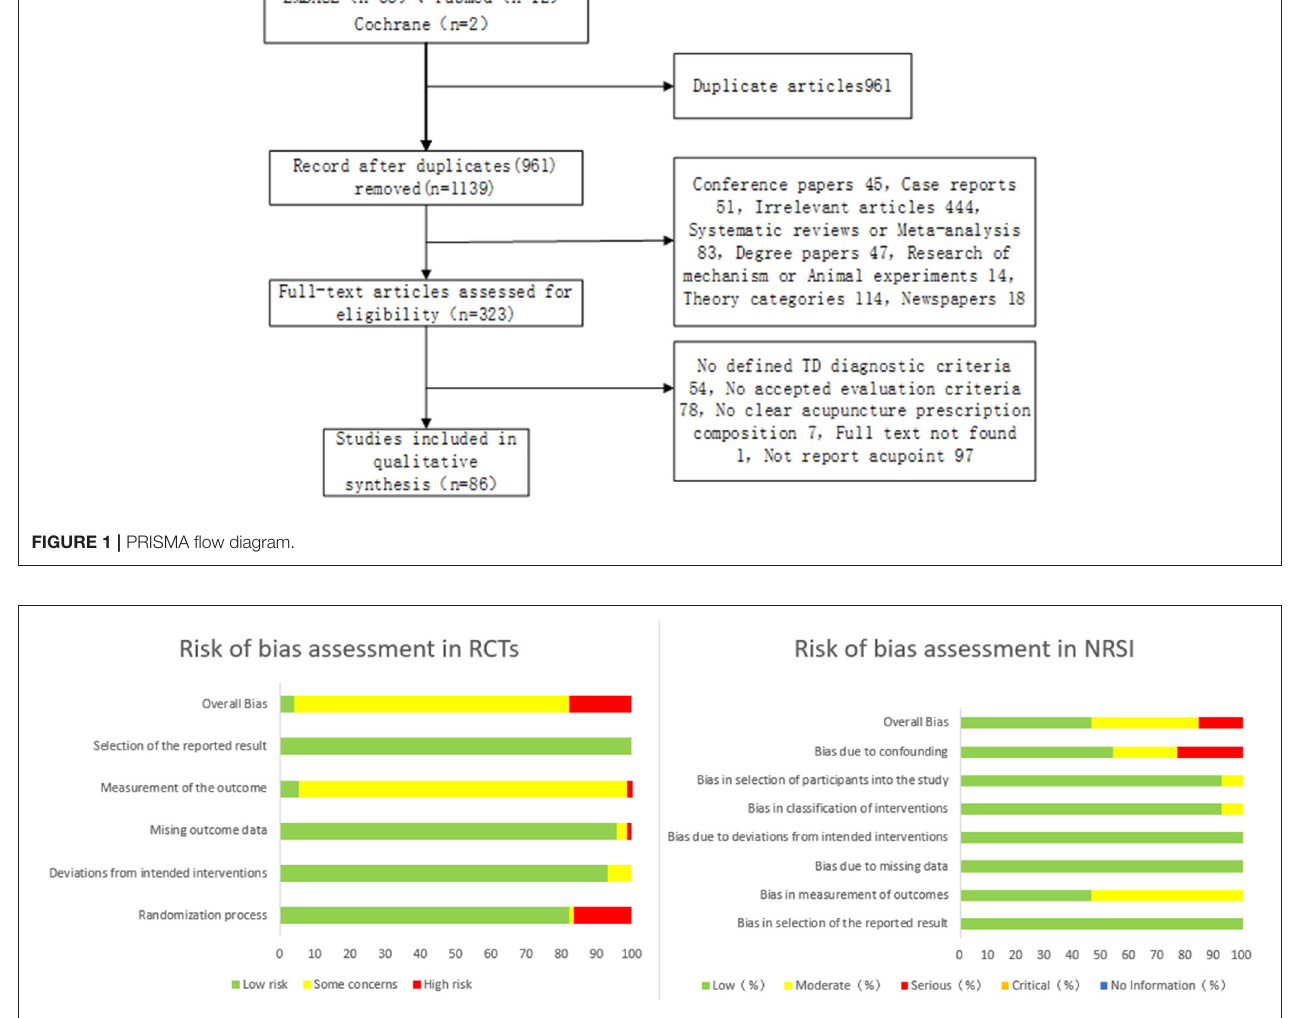
FIGURE 2 | Risk of bias